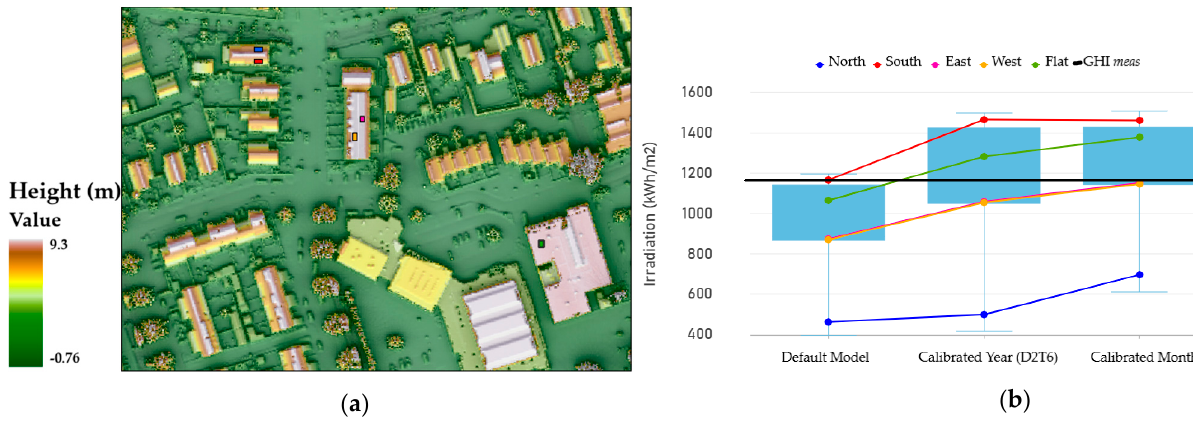
Figure 9. ( a ) Colorized digital elevation models (DEM) with selected areas on different roof orientations and slopes. ( b ) box plot of irradiation values in the images for the default and calibrated models for 2020 with mean lines from the selected areas of different roof types.